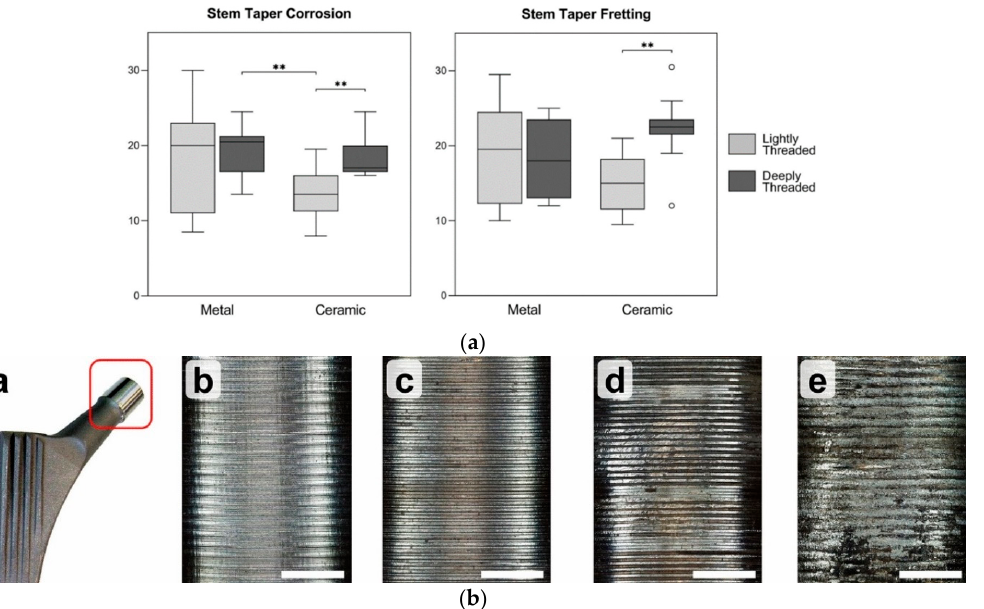
Figure 9. ( a ) The influence of the surface roughness on the fretting and corrosion damage of the trunnions mated with ceramic and metallic heads in Stockhausen et al. [26]. Double asterisks and circles denote highly significant differences ( p ≤ 0.01), and maximum/minimum damage, respectively ( b ) Four main categories for classification of the damage severity: no damage, mild, moderate, and severe, respectively, from left to right.